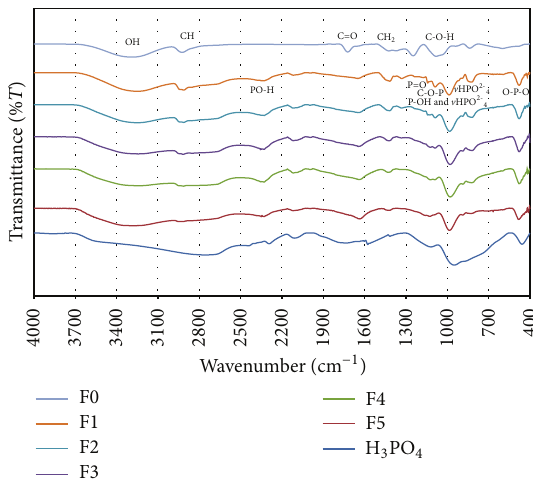
Figure 1: FTIR spectra of PVA and PPVA